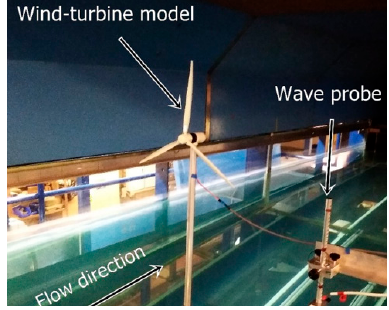
Figure 7. Initial physical model of the wind turbine.